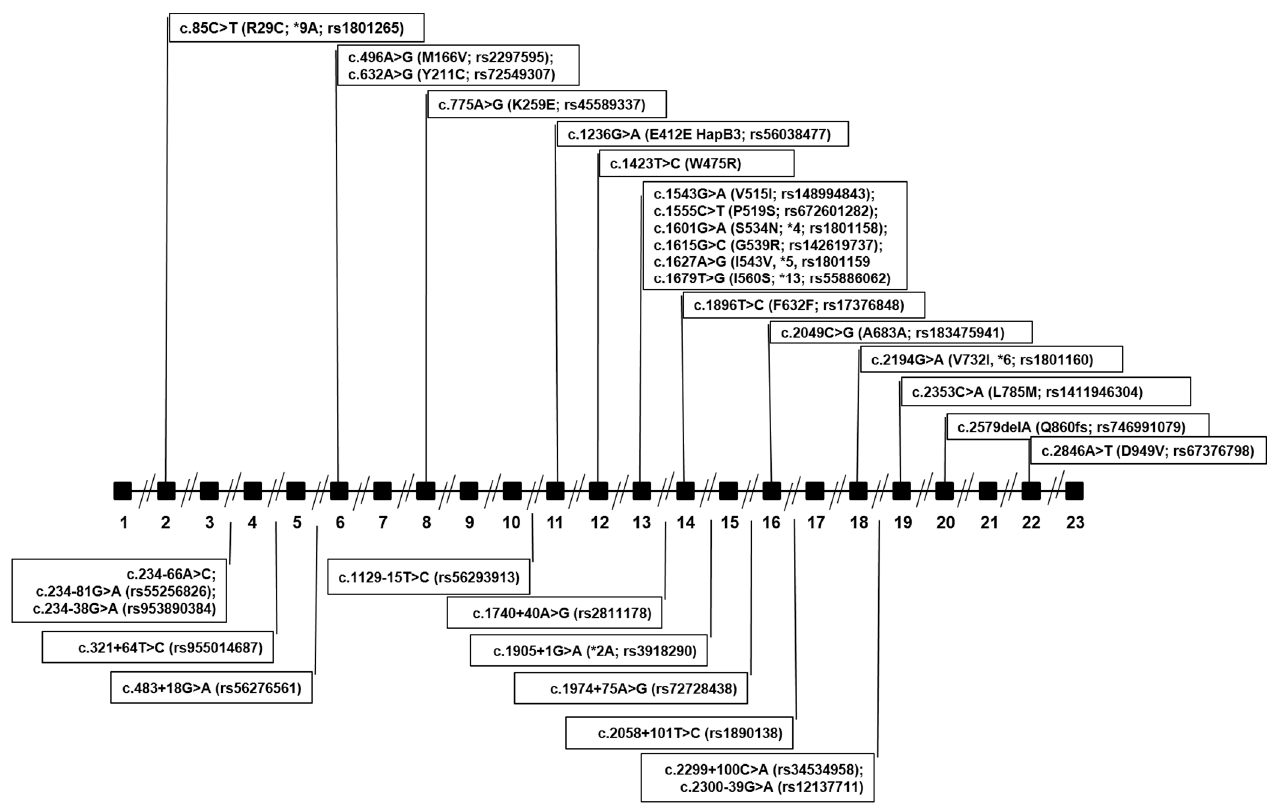
Figure 1. Gene location of DPYD variants detected by NGS sequencing. Black boxes represent exons, lines represent introns.